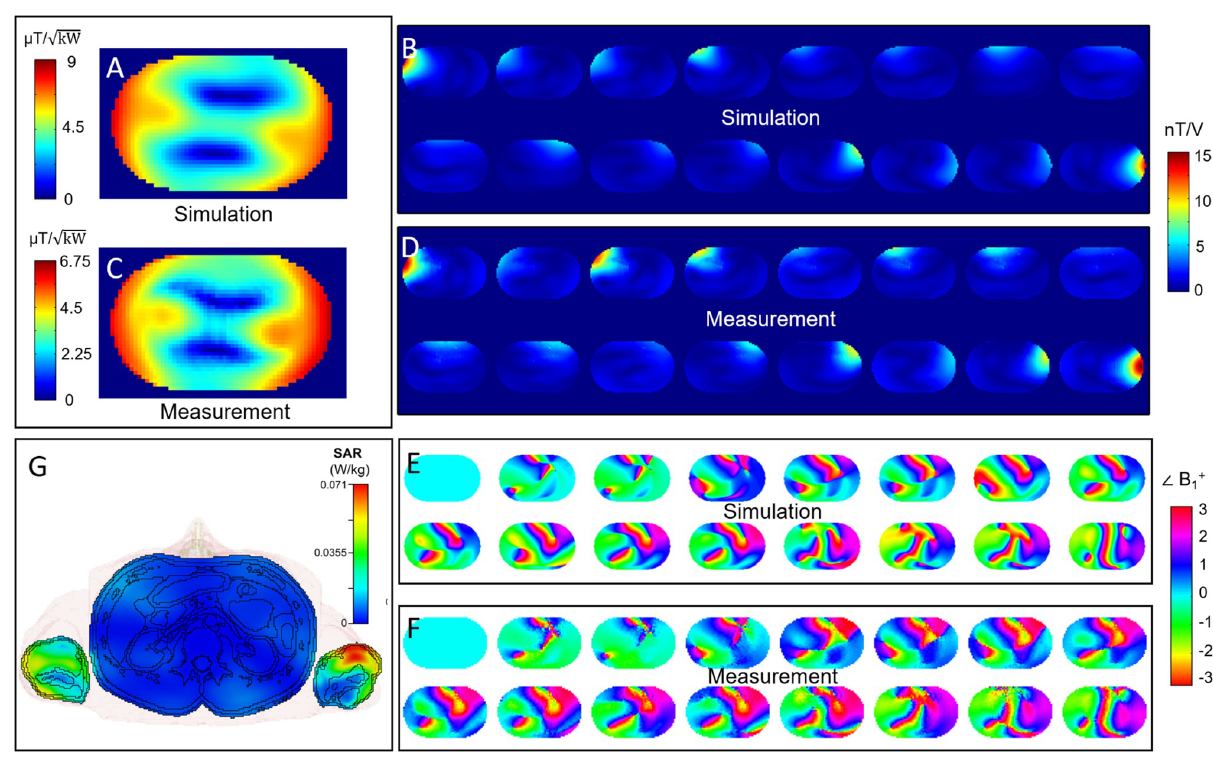
Fig 7. Phantom B 1 maps and SAR distribution. Comparison of simulated B 1+ maps (A,B,E) and measured B 1+ maps (C,D,F) in the body-sized phantom. Please note that only half of the channels are shown for better depiction. G shows an axial cut through the body model at the position of the highest SAR in the CP+ mode, with the SAR distribution normalized to 1 W total input power as an overlay.